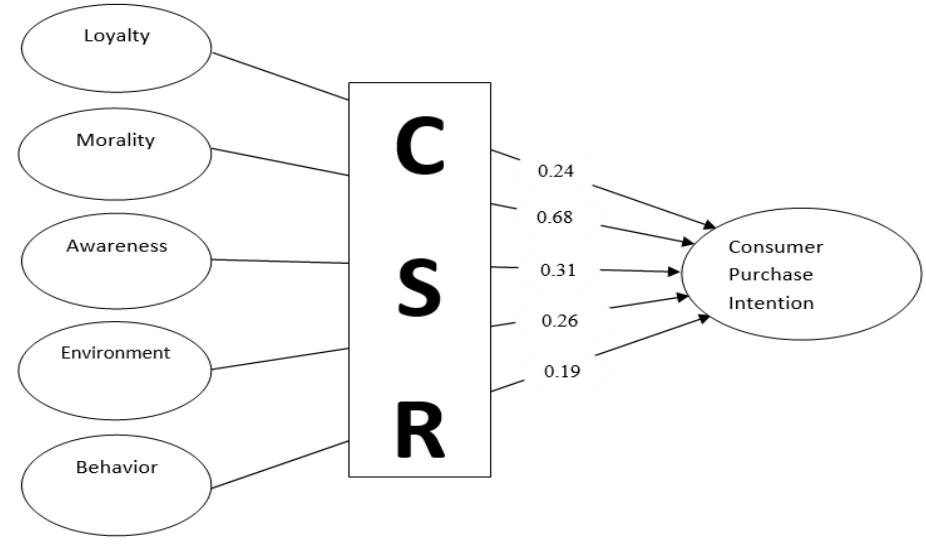
Fig. 3. SEM analysis